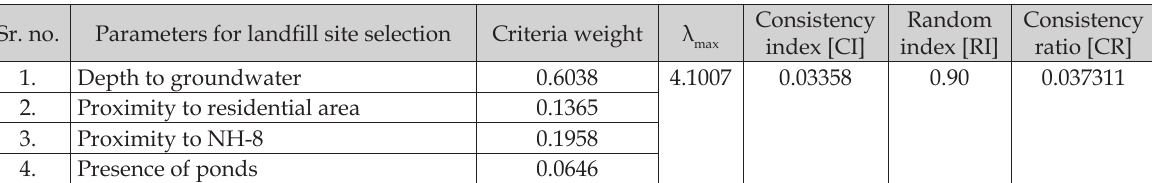
Table 4. Calculated value of criterion weight, CI, RI,